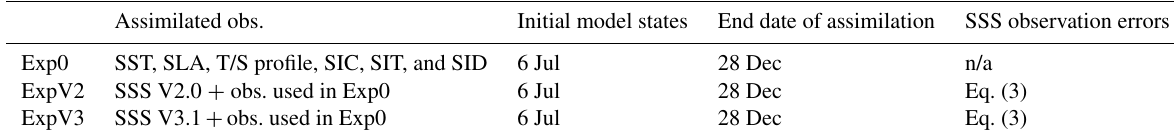
Table 1. Settings of the three assimilation runs in 2016 with and without SSS. Assimilated obs.